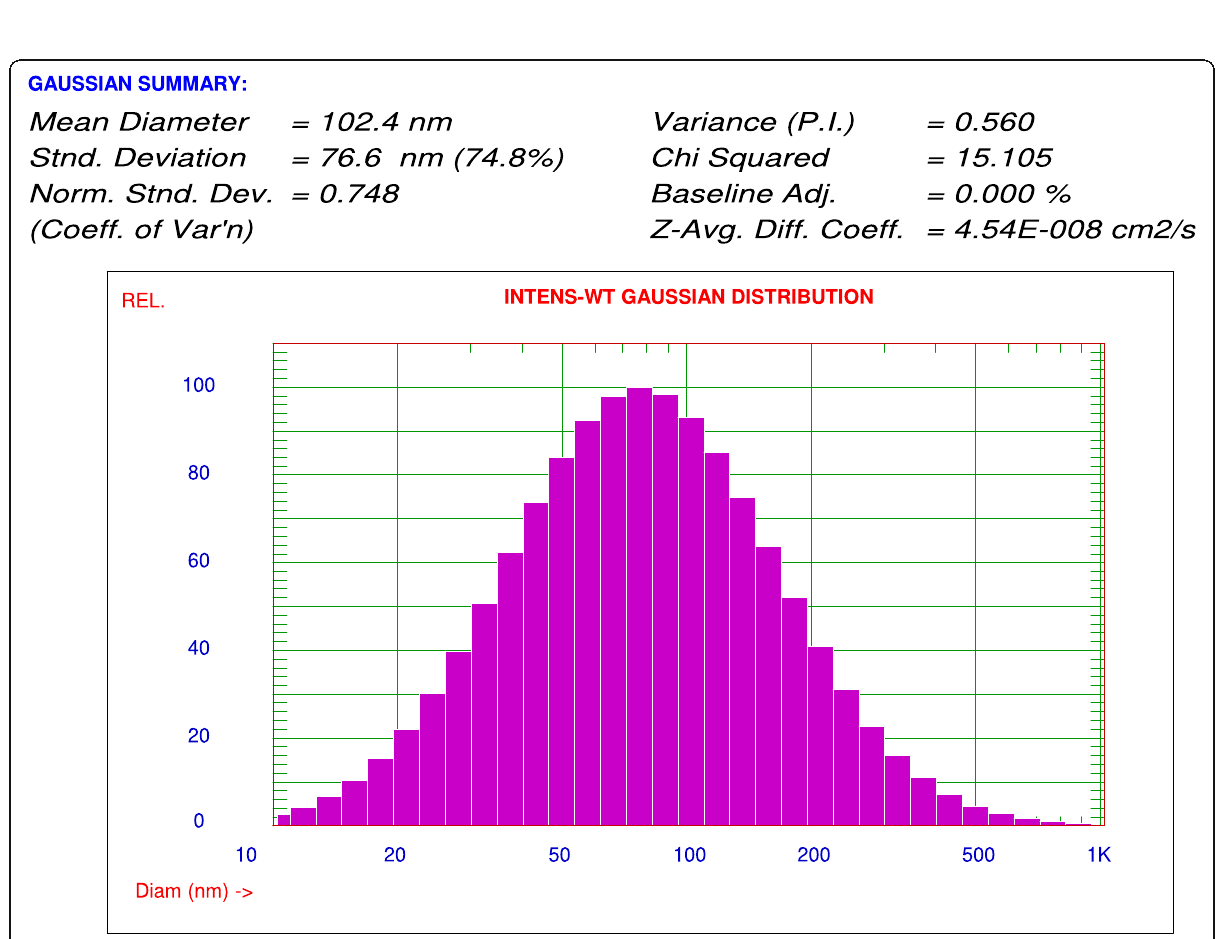
Fig. 7 DLS report for the particle size of the optimized nanoparticle